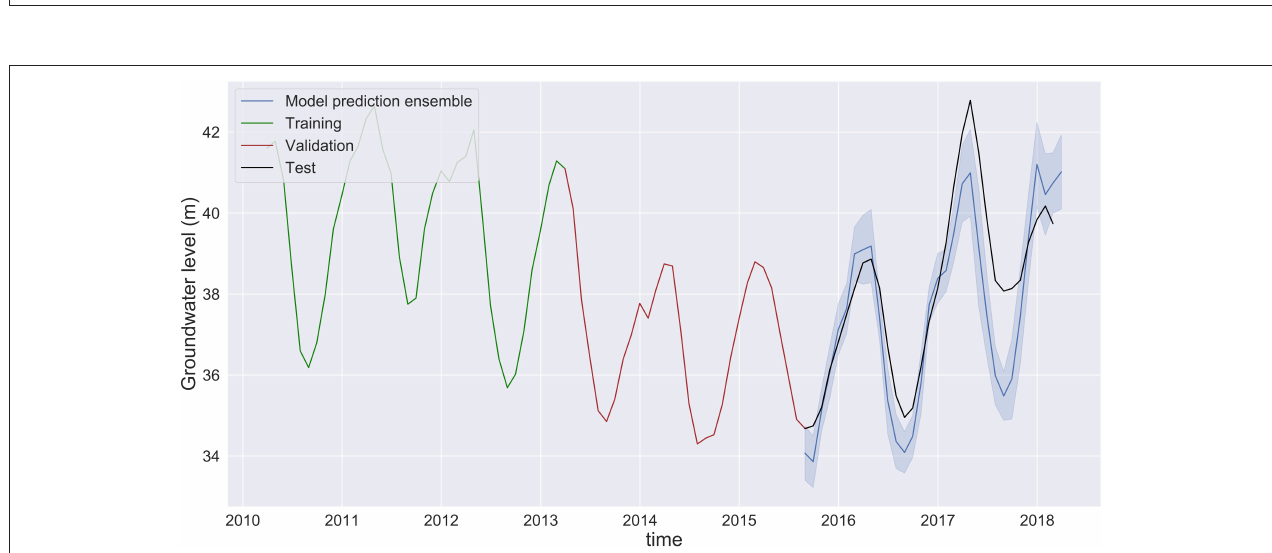
FIGURE 7 | Groundwater level prediction at Butte with input features: groundwater and temperature. Large differences between the ensemble mean (dark blue) and observed (black) show low prediction accuracy. The high variability of the predictions of individual ensemble members (blue band) shows that the MLP model is not reliable. Predictions made by MLP models in Shasta and Tehama are provided in Supplementary Figures 18, 19 .